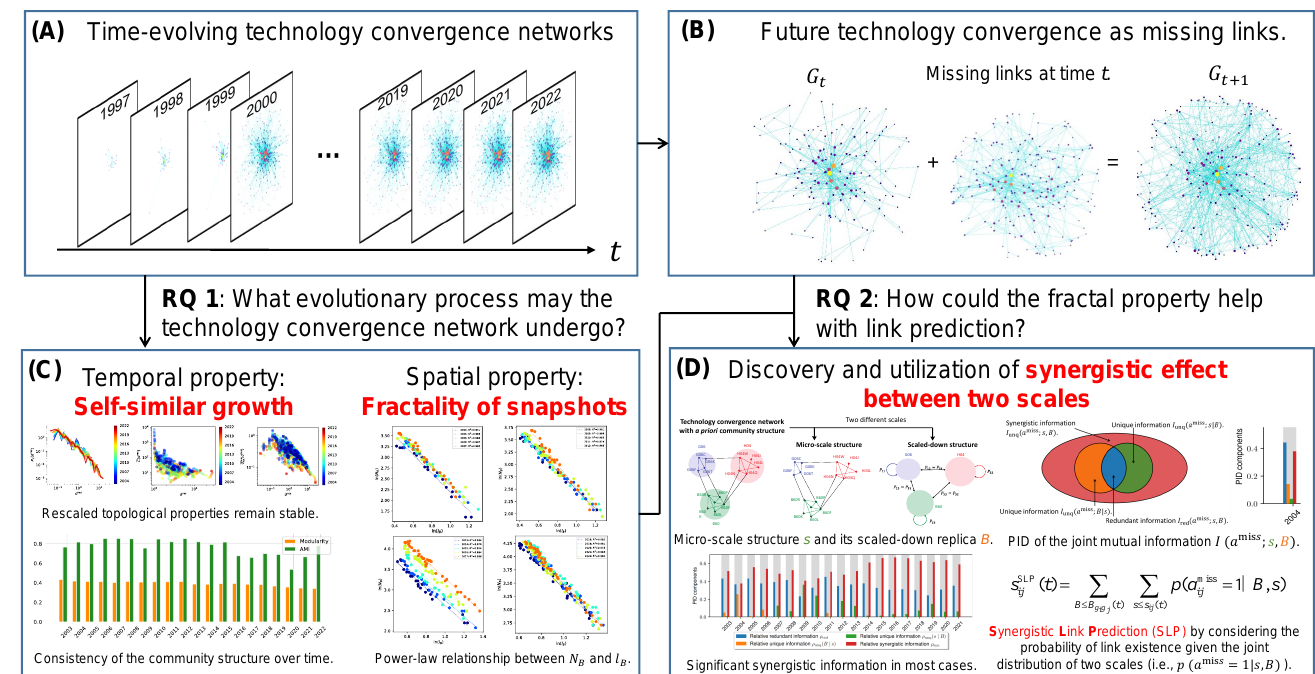
Figure 1. The research framework and main findings of this study. Sub-figure ( A ) shows the time- evolving technology-convergence network, in which each year’s snapshot is constructed based on patent applications up to that year; that is, the future technology convergence at time t + 1 could be regarded as missing links of the snapshot at time t . Sub-figure ( B ) shows the formulation of technology convergence anticipation as a link-prediction problem. Two main research questions of this study (i.e., RQ 1 and RQ 2) are answered in sub-figures ( C , D ), respectively. Sub-figure ( C ) presents the empirical evidence for the self-similar growth and the fractality of snapshots. Sub-figure ( D ) demonstrates that a synergistic effect between two scales on link prediction is discovered based on PID, and this synergistic effect is utilized via a SLP approach by considering the probability of a link’s existence being conditional on the joint distribution of two